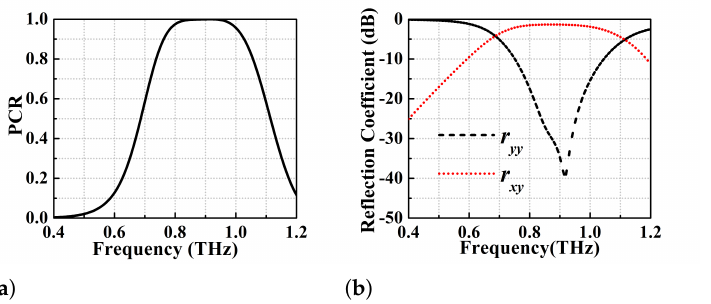
Figure 4. Ideal polarisation conversion efficiency analysis of the optimized design of l 1 = 110 µ m ( a ) 100% PCR ( b ) co-pol ( r yy ) and cross-pol ( r xy ) reflection